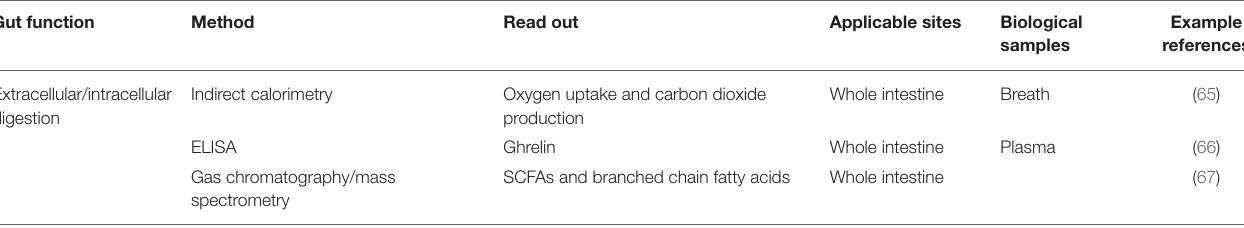
TABLE 2 | Methods described in literature to measure extracellular digestion.